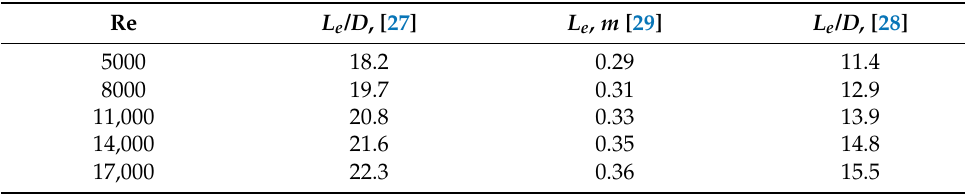
Figure 7. Effect of the Pr number on the development of HT in a tube